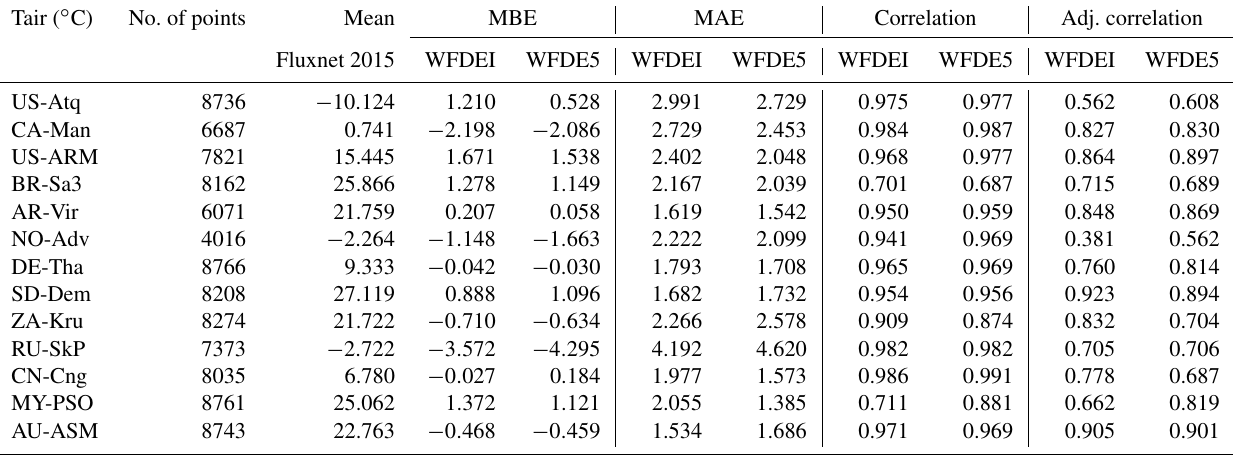
Table A9. Tair metrics for each FLUXNET2015 site: WFDEI versus FN2015 and WFDE5 versus FN2015 at 3-hourly time steps. Tair ( ◦ C)